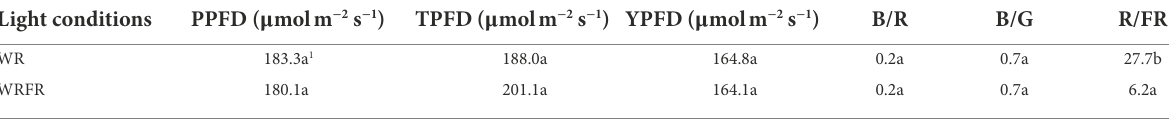
TABLE 1 Spectral characteristics of the two light conditions WR and